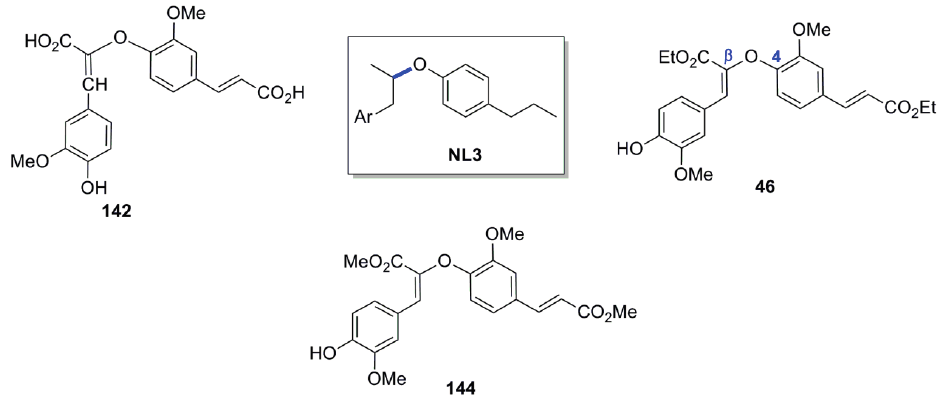
Figure 13. The structure of FerA and Et-Fer dimers 142 , 46 and 144 respectively, as examples of the NL3